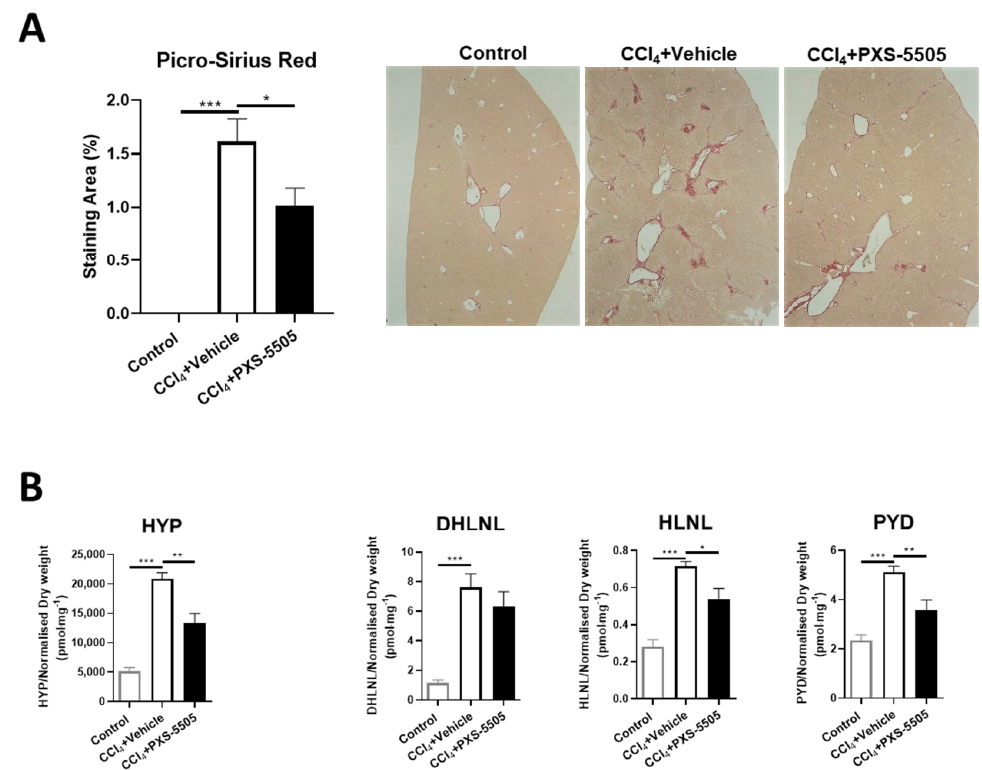
Figure 7. The effect of PXS-5505 treatment on CCl4-induced liver fibrosis and collagen crosslinks in mouse lung. ( A ) Representative images of liver stained with Picro-Sirius red, differentiating collagen (red) from hepatocytes (yellow) with quantification of the staining area, showing significantly elevated percentage of collagen deposited area in the mice administered with CCl4 compared to the normal mice, and the fibrotic area reduced in the CCl4 group subjected to PXS-5505 treatment compared to the vehicle treated group. ( B ) CCl4 administration elevated the expression of hydroxyproline (HYP), immature [dihydroxy-lysinonorleucine (DHLNL) and hydroxylysinonorleucine (HLNL)] and mature [pyridinoline (PYD)] collagen crosslinks in the mouse liver; PXS-5505 treatment ameliorated these elevated markers induced by CCl4. (* p < 0.05, ** p < 0.01, *** p < 0.001 between the indicated